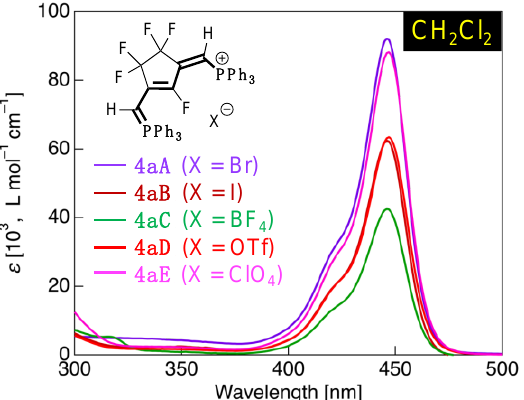
Figure 9. UV-vis absorption spectrum of 4aA - 4aE with various counter anions (X) in CH 2 Cl 2 (con- centration = 1.0 × 10 –5 mol · L –1